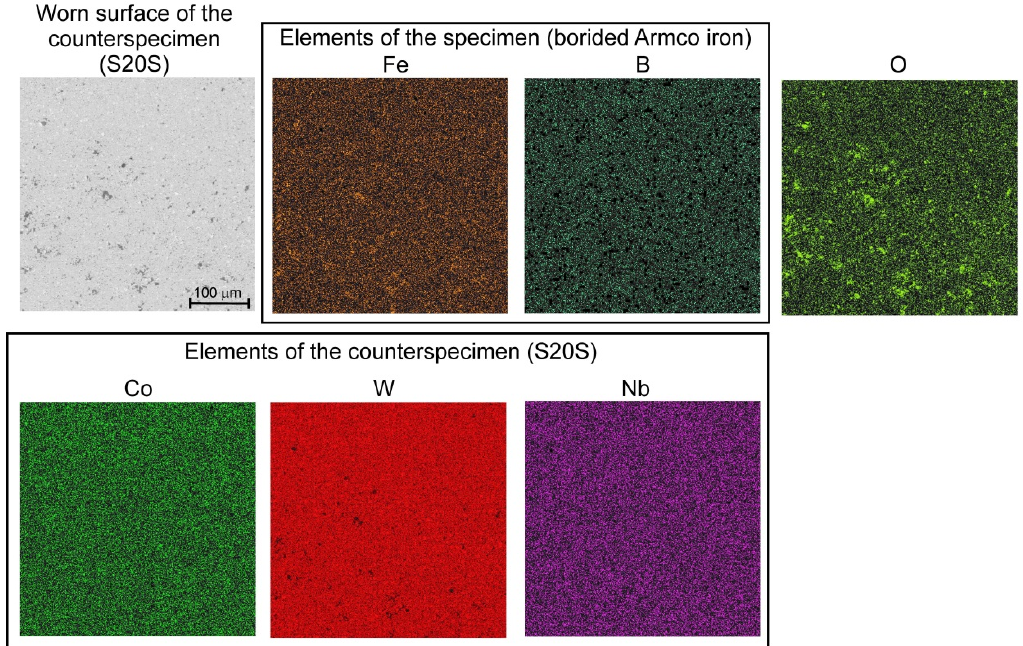
Figure 11. The worn surface and EDS pattern of counter-specimen (S20S) after wear test of gas borocarburized Armco iron.